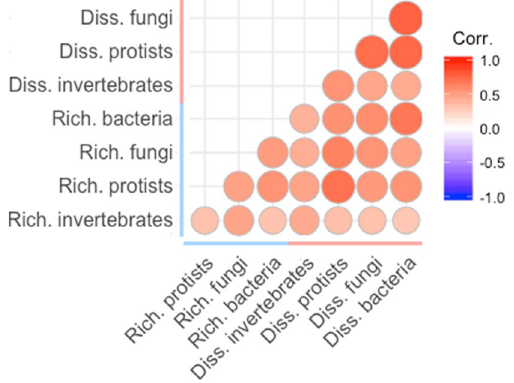
Figure 2. Spearman Rank significant correlations (P < 0.05) among the spatial variability of the soil richness and community composition dissimilarity of the different